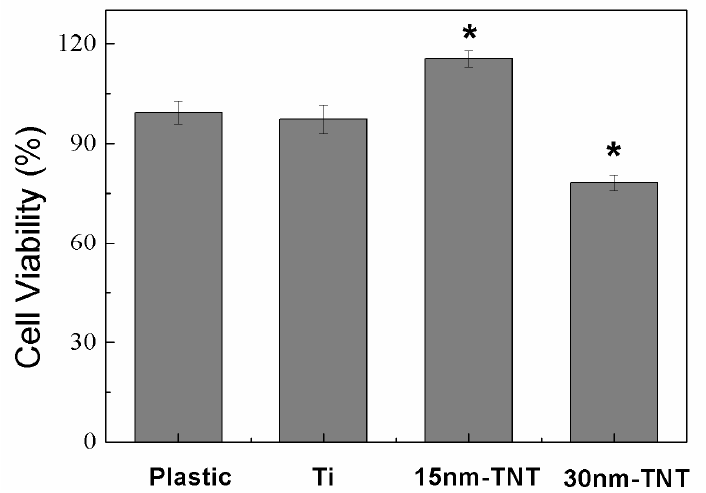
nanotube array ( * p < 2